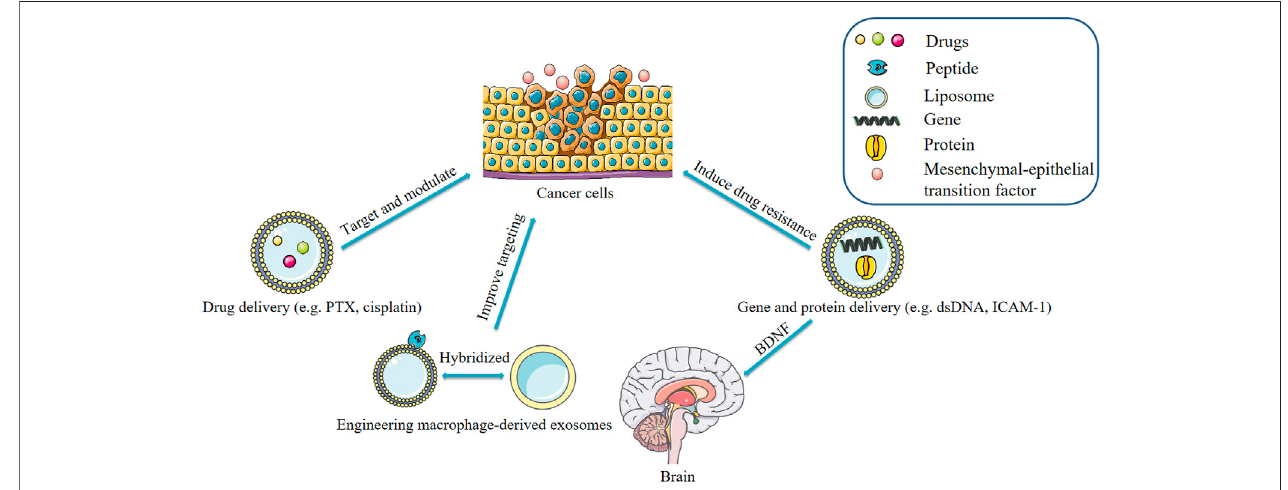
FIGURE 4 | Applications of macrophage-derived